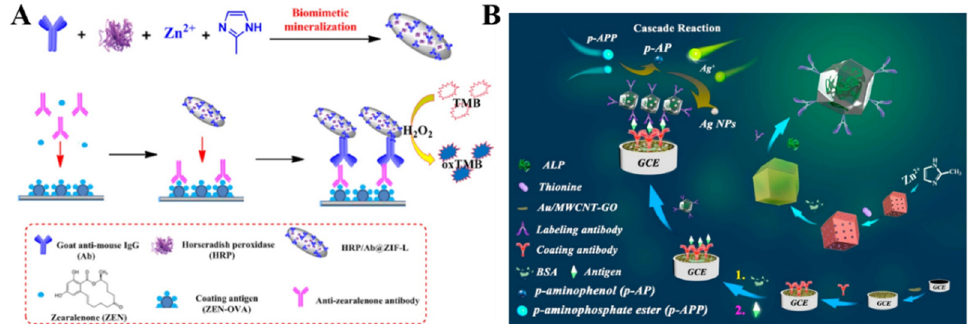
Figure 9. ( A ) Schematic illustration of the synthetic process for HRP/Ab@ZIF-L and the corresponding HRP/Ab@ZIF-L − based ELISA for the detection of ZEN. Reprinted with permission from Ref. [215]. Copyright 2021, Elsevier. ( B ) Schematic illustration of the construction steps and mechanism of a dual-labeling ZIF-8-based immunosensor for the electrochemical detection of tumor markers. Reprinted with permission from Ref. [217]. Copyright 2021, Elsevier.